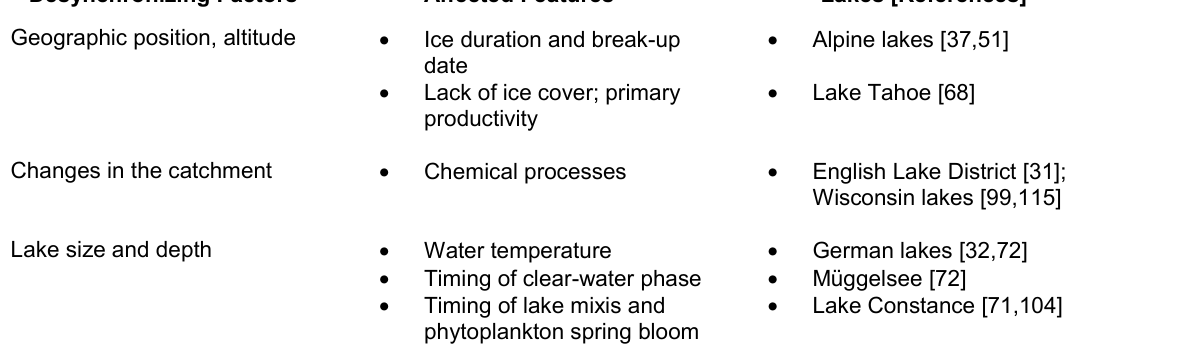
Known Factors Potentially Preventing Lake Features and Lake-Internal Processes from NAO- or ENSO-Induced Synchronisation* Desynchronizing Factors Affected Features Lakes [References] Geographic position,